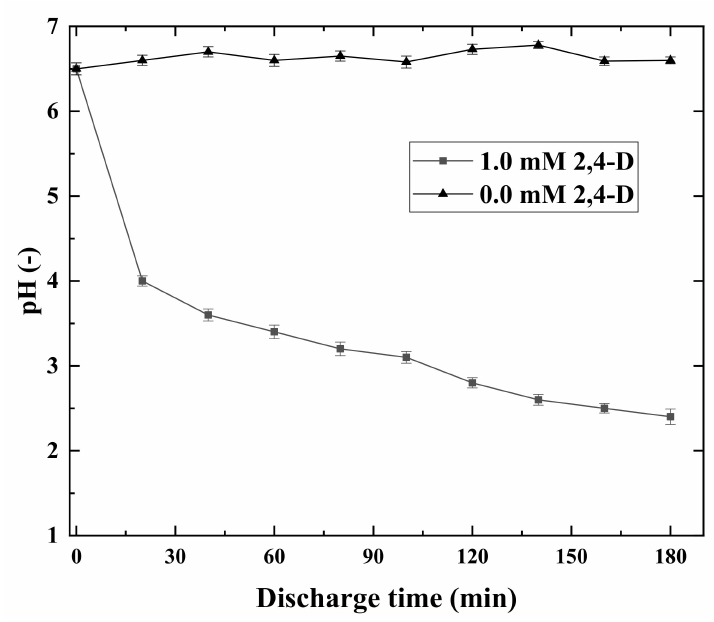
Figure 3. Variations of pH in the presence and absence of 2,4-D during RFD treatment (input power, 200 W; [2,4-D] 0 , 1.0 mM; initial pH,